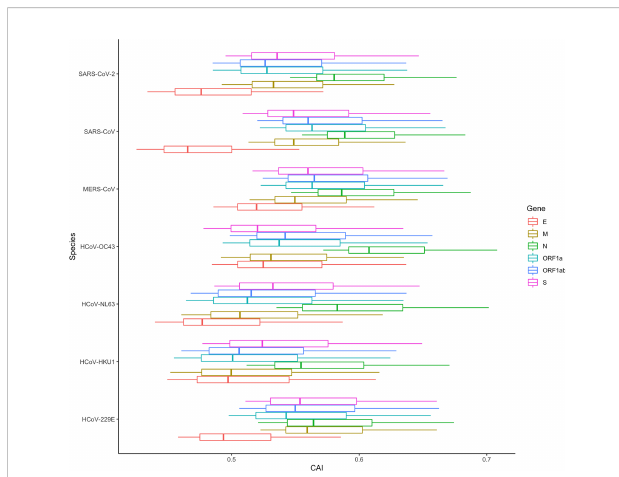
FIGURE 15 The overall CAI value distribution of ORFs for the reference genomes of seven different coronaviruses in all cell types/large groups from the lung scRNA-seq dataset shown by box plot. Each box shows the CAI